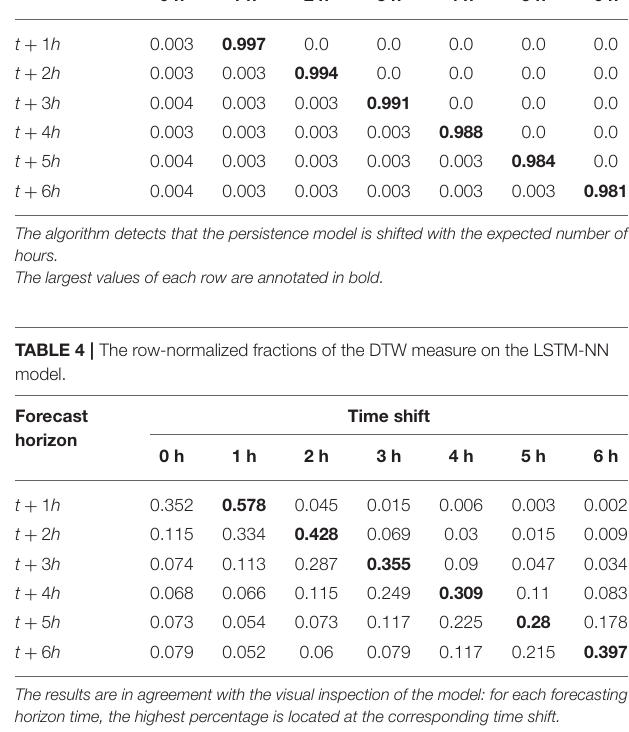
TABLE 3 | The row-normalized fractions of the warping measure on the persistence model. Forecast horizon